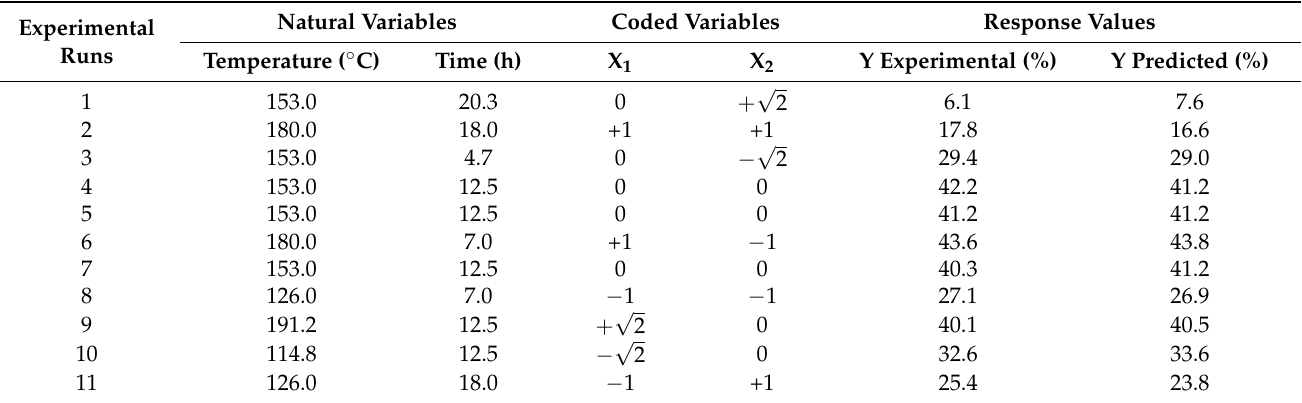
Table 1. Experimental design matrix for the synthesis of BiOI/mordenite composites and response values expressed as removal efficiencies (Y, %) obtained after 20 min of photocatalytic oxidation of caffeic acid under simulated solar